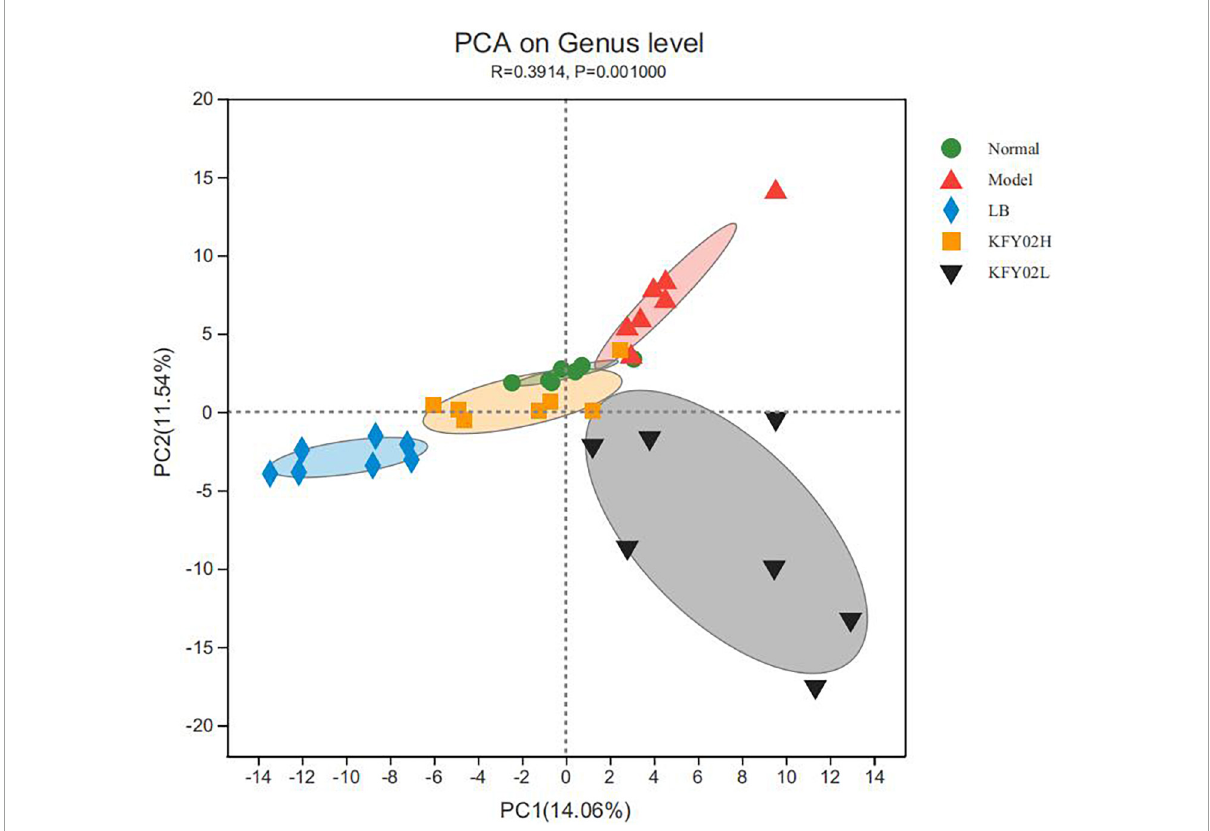
FIGURE3 Principal component analysis (PCA) of mice feces. Each colored symbol represents the composition of fecal microbiota of one mice. LB: mice administered with 1 × 10 9 CFU/kg LB, KFY02H: mice administered with 1 × 10 9 CFU/kg LP-KFY02, KFY02L: mice administered with 1 × 10 8 CFU/kg